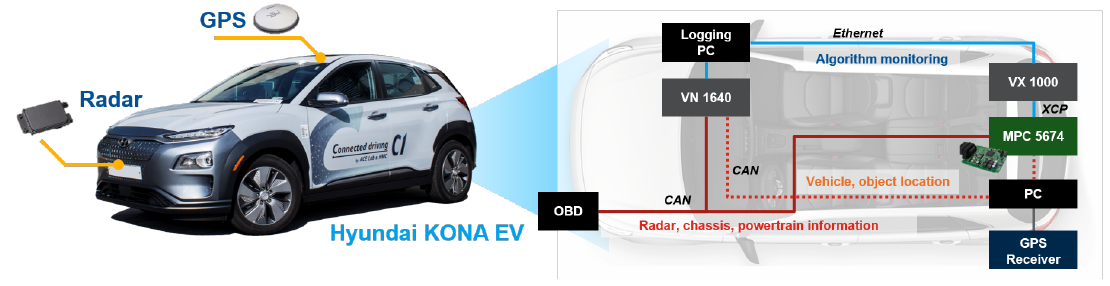
Figure 2. Vehicle configuration.